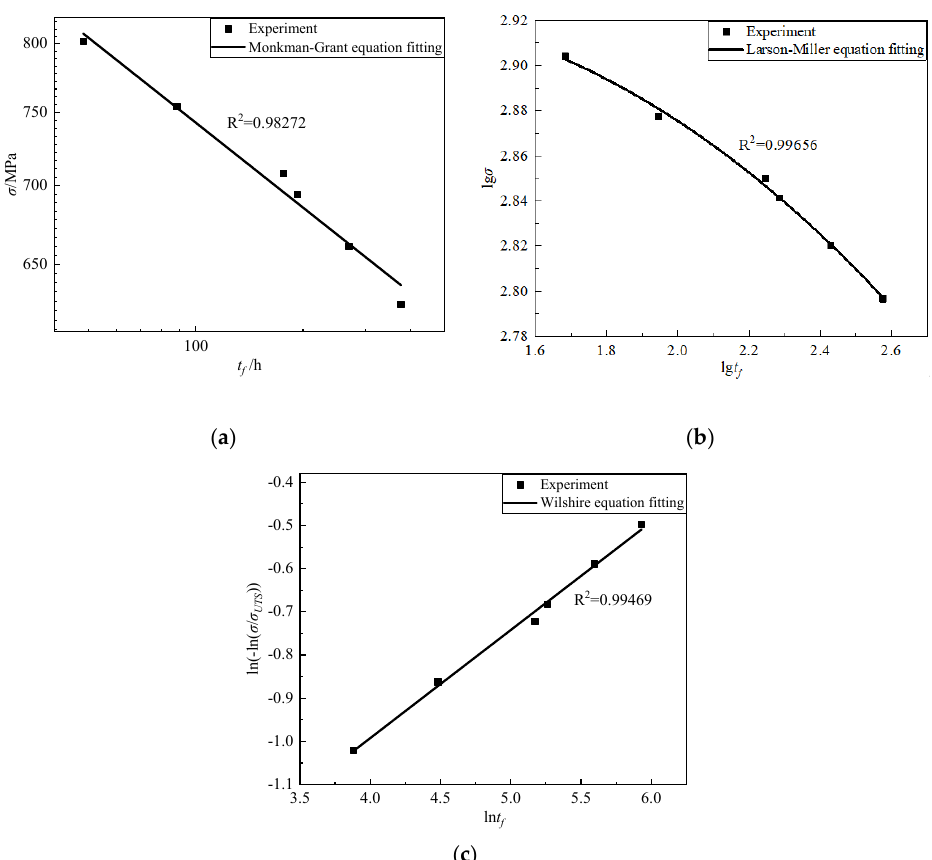
Figure 11. Creep life fitting results of unnotched specimens: ( a ) Monkman–Grant equation; ( b ) Larson–Miller equation; ( c ) Wilshire equation.